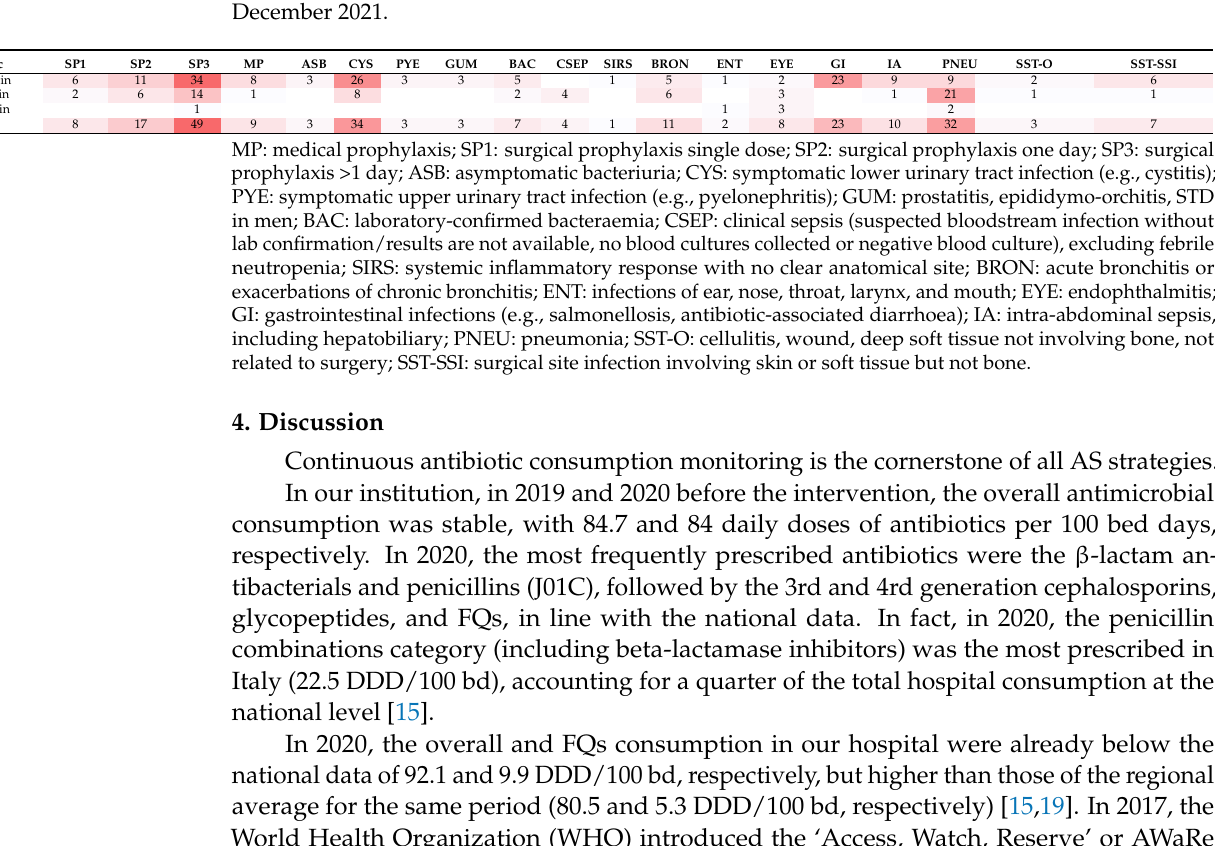
Table 4. Heat map—motivations for fluoroquinolones prescription (n. of